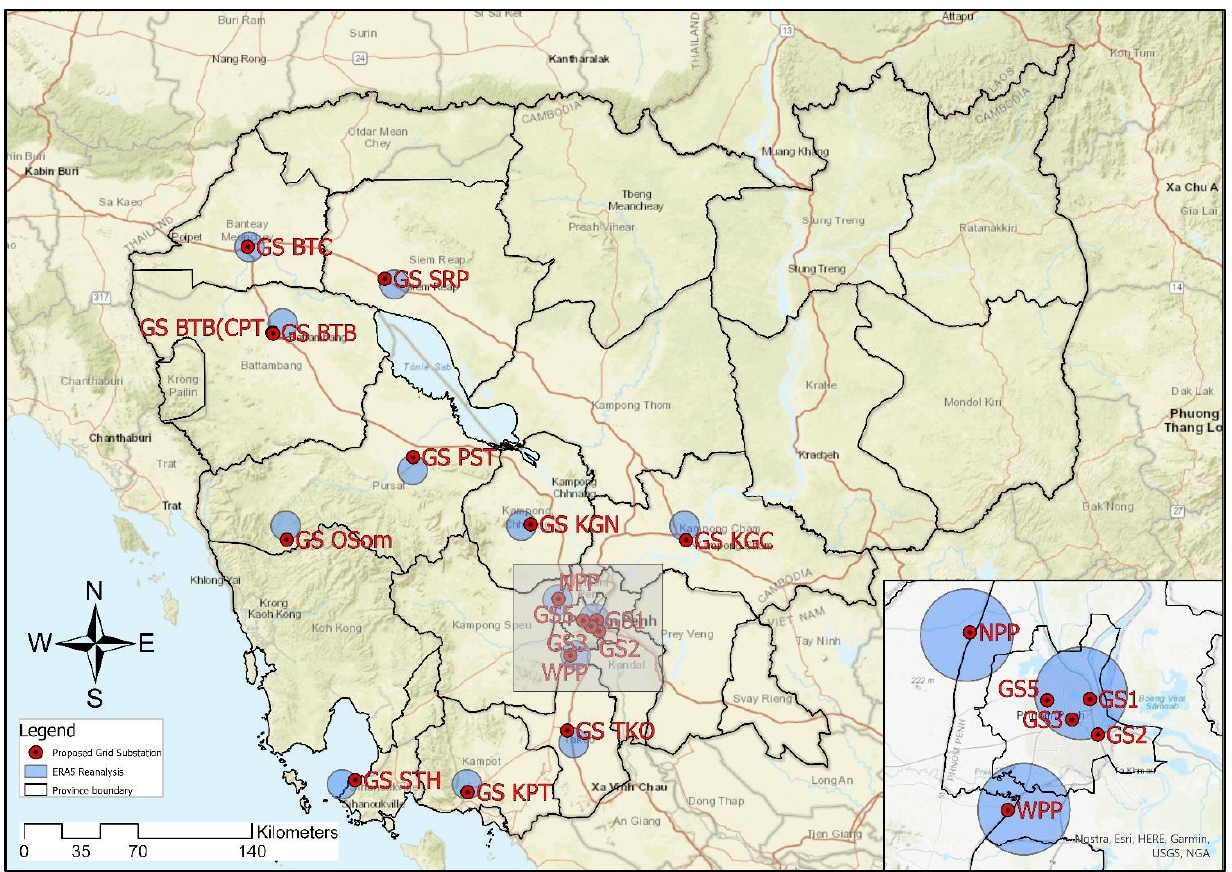
Figure 1. Map of the study areas in Cambodia with the locations of grid substations (GSs) and the nearest grid points of the ECMWF-ERA5 reanalysis to the GSs in blue-shaded circles. Table 1. Power demand information of the substations considered in this study and the nearest grid point information of ECMWF-ERA5 reanalysis with spatial and temporal resolutions.